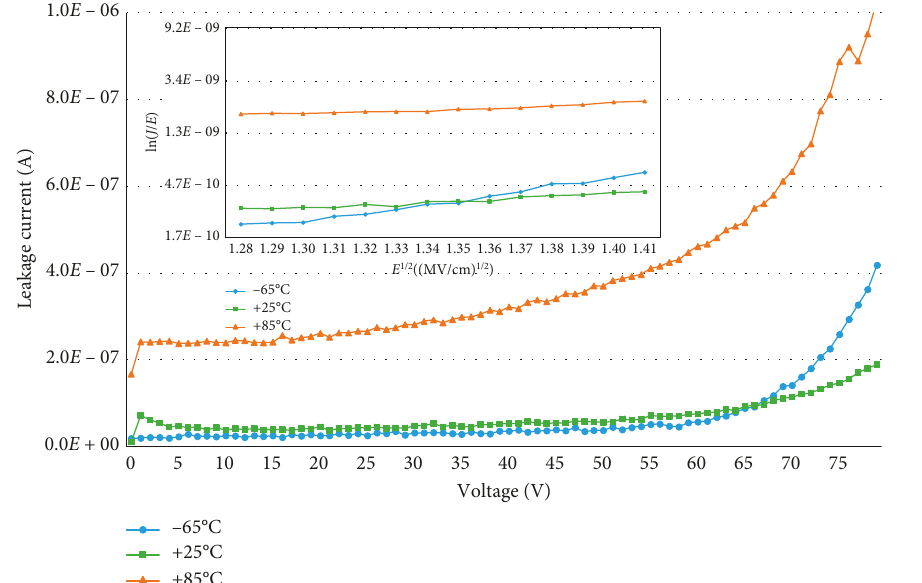
Figure 5: PF emission saturation observed in 63V 10 μ F chip tantalum capacitors. The I - V curve at − 65 ° C converges with the curve at +25 ° C near 65 V. There is no converged point with the curve of 85 °